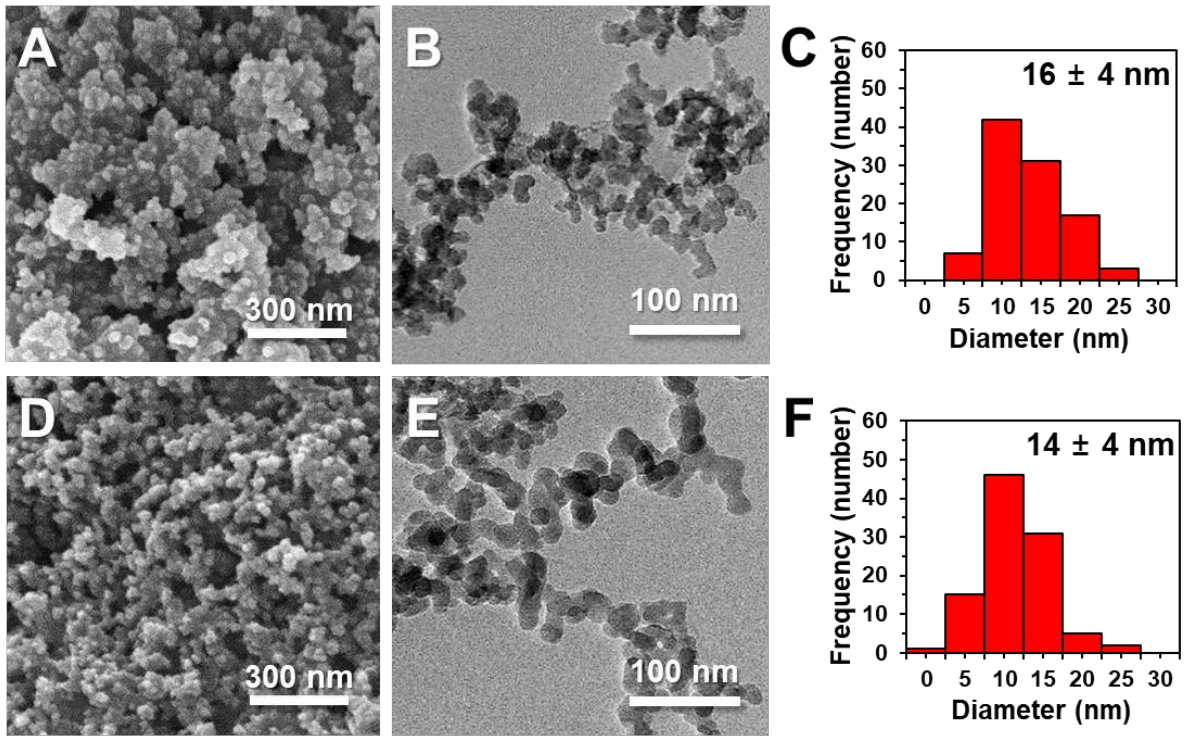
Figure 1. ( A , D ) Scanning electron microscopy ( SEM), ( B , E ) transmission electron microscopy (TEM), and ( C , F ) size distribution of ( A – C ) precipitated SiO 2 and ( D – F ) fumed SiO 2 . Size distributions were obtained by randomly selecting at least 100 particles from the TEM images. Table 1. Particle fractions, hydrodynamic diameters, and specific surface areas 1 of precipitated SiO 2 and fumed SiO 2 . Samples